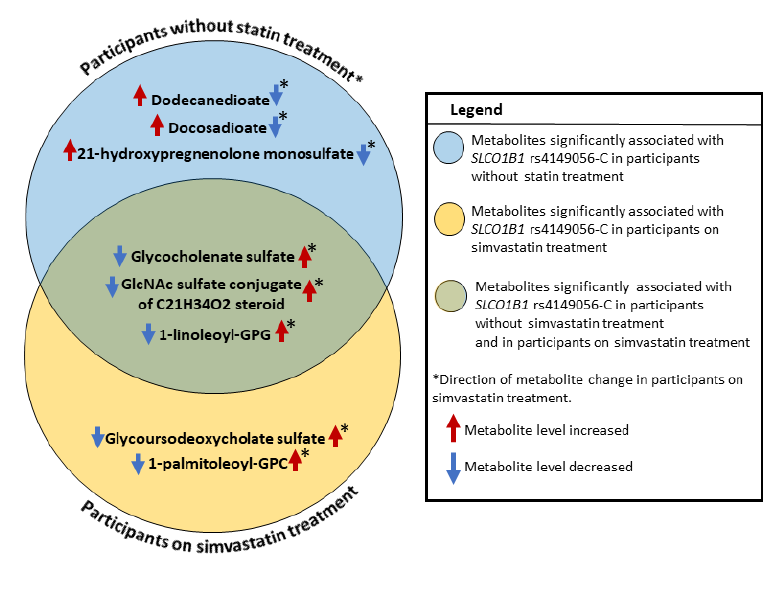
Figure 2. Metabolites significantly associated with SLCO1B1 rs4149056-C in the participants without statin treatment and the participants on simvastatin treatment. Abbreviations: GPC, glycerophos- phatidylcholine; GPG, glycerophosphatidylglycerol.